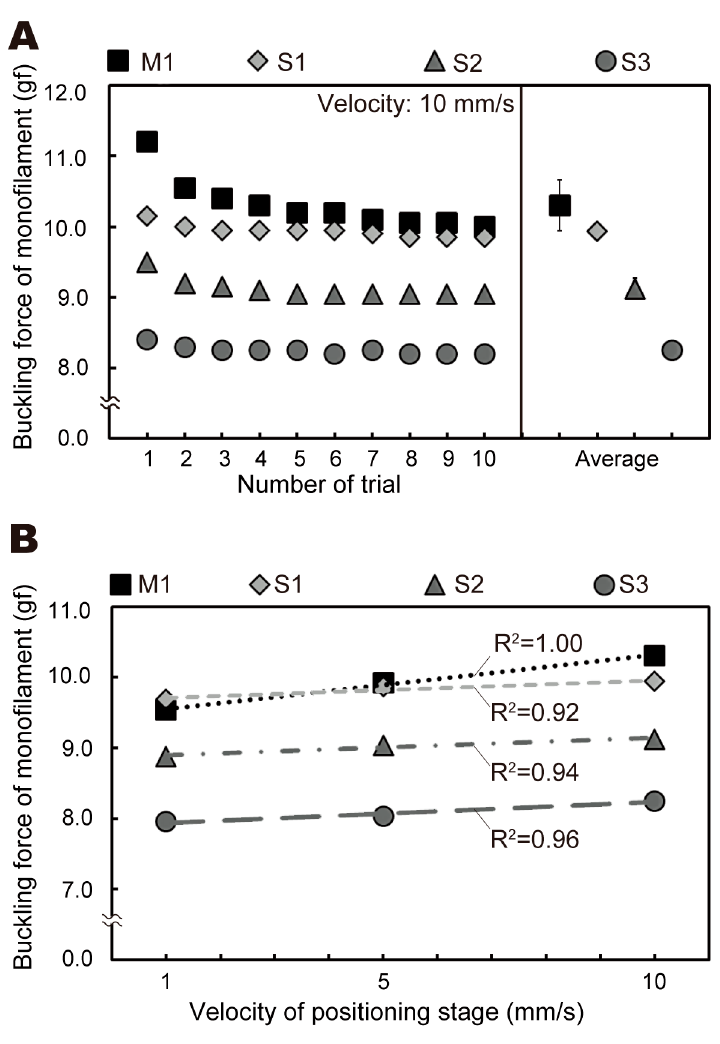
Figure 5. Experimental buckling force results for different monofilament types under automated operation using all four monofilaments, with one multi-use monofilament (denoted M1) and three single-use monofilaments (denoted S1, S2, and S3): ( A ) for each trial and ( B ) as a function of positioning stage velocity.